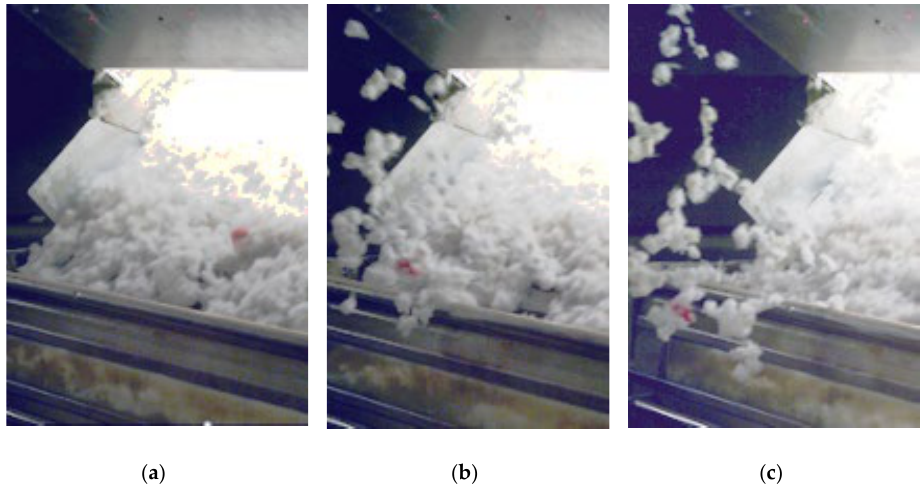
Figure 6. Plastic-inspection-detection-and-ejection system (PIDES) plastic removal system in oper- ation, taken with high-speed video. ( a ) shows target just before ejection, after detection. ( b ) shows target during ejection process, and ( c ) shows target after ejection is complete.